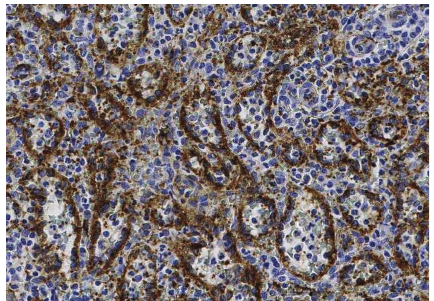
Figure 3: Photomicrograph × 20 magnification. The neoplastic cells express FVIII.